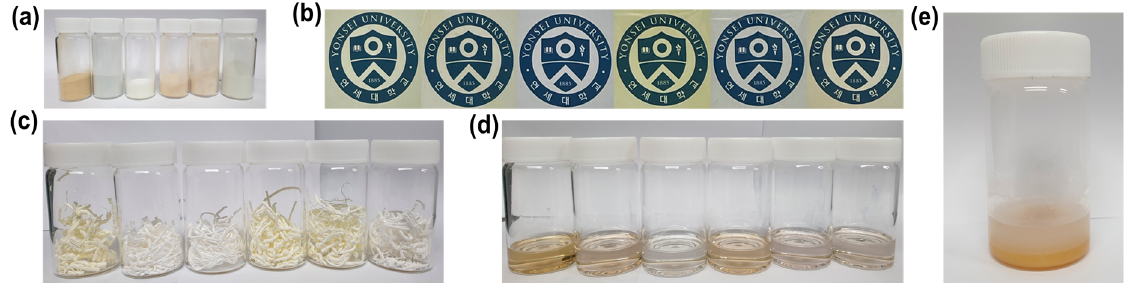
Figure 5. ( a ) polyimide powders in 20 mL vial: resultants of hydrothermal process. ( b ) polyimide films: resultants of thermal imidization. ( c ) polyimide fibers in 70 mL vial: resultants of thermal imidization. ( d ) poly(amic-acid) solution in 70 mL vial. ( e ) poly(amic-acid) damaged by atmospheric moisture in 70 mL vial.